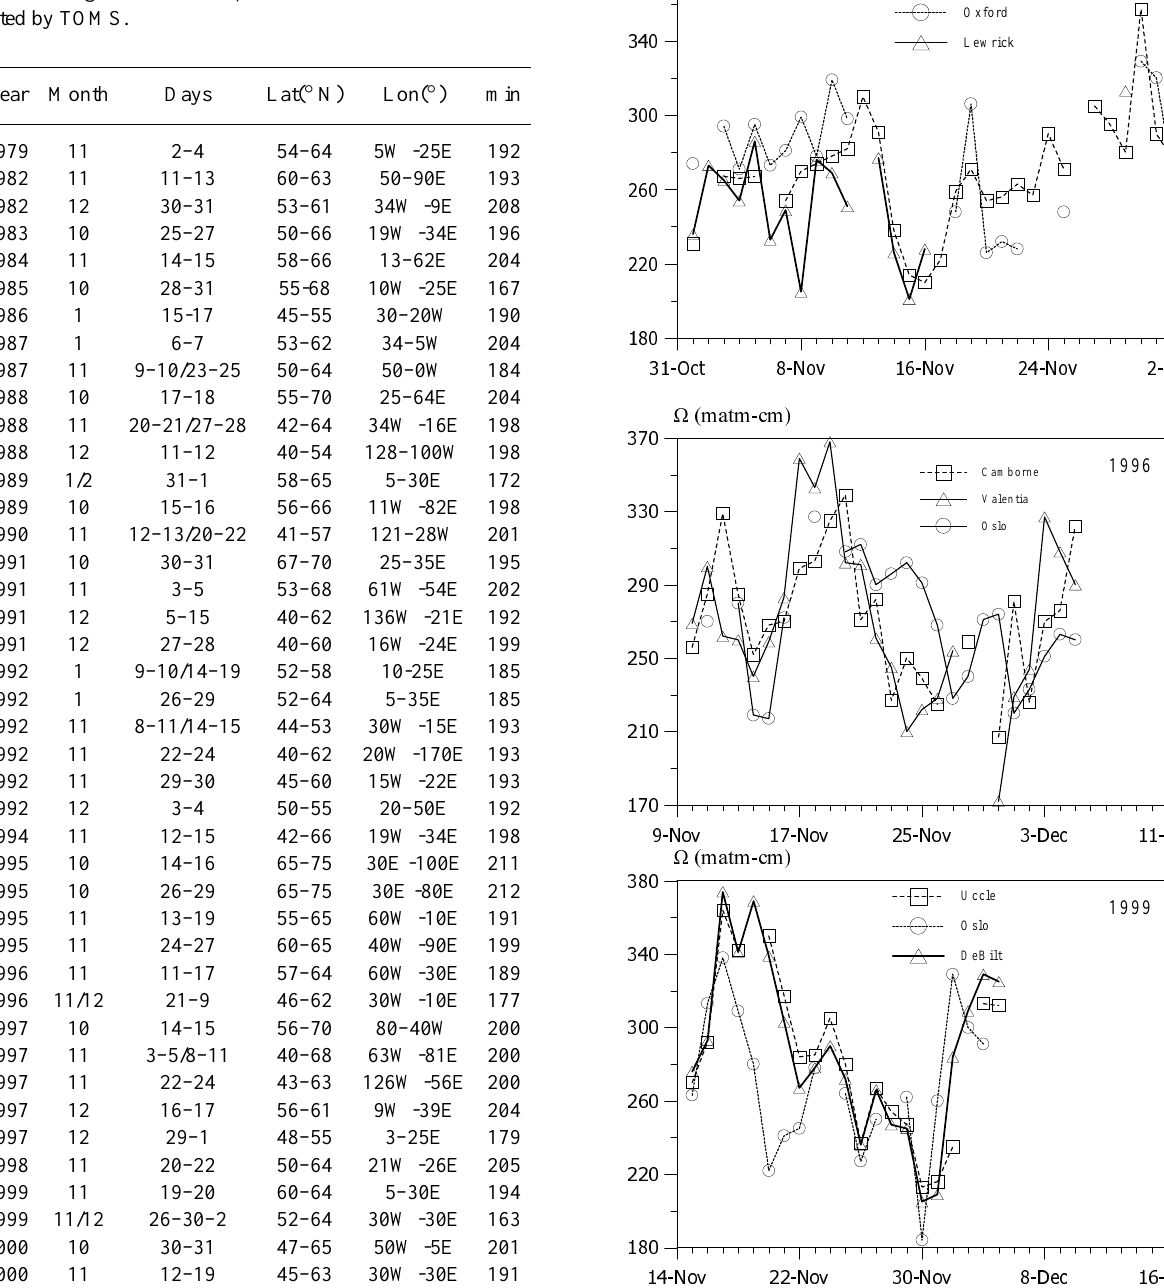
Table 3. Periods longer than one day with total ozone < 220 matm- cm over areas greater than 500,000 km 2 in the 40–65 ◦ N latitudes detected by TOMS.